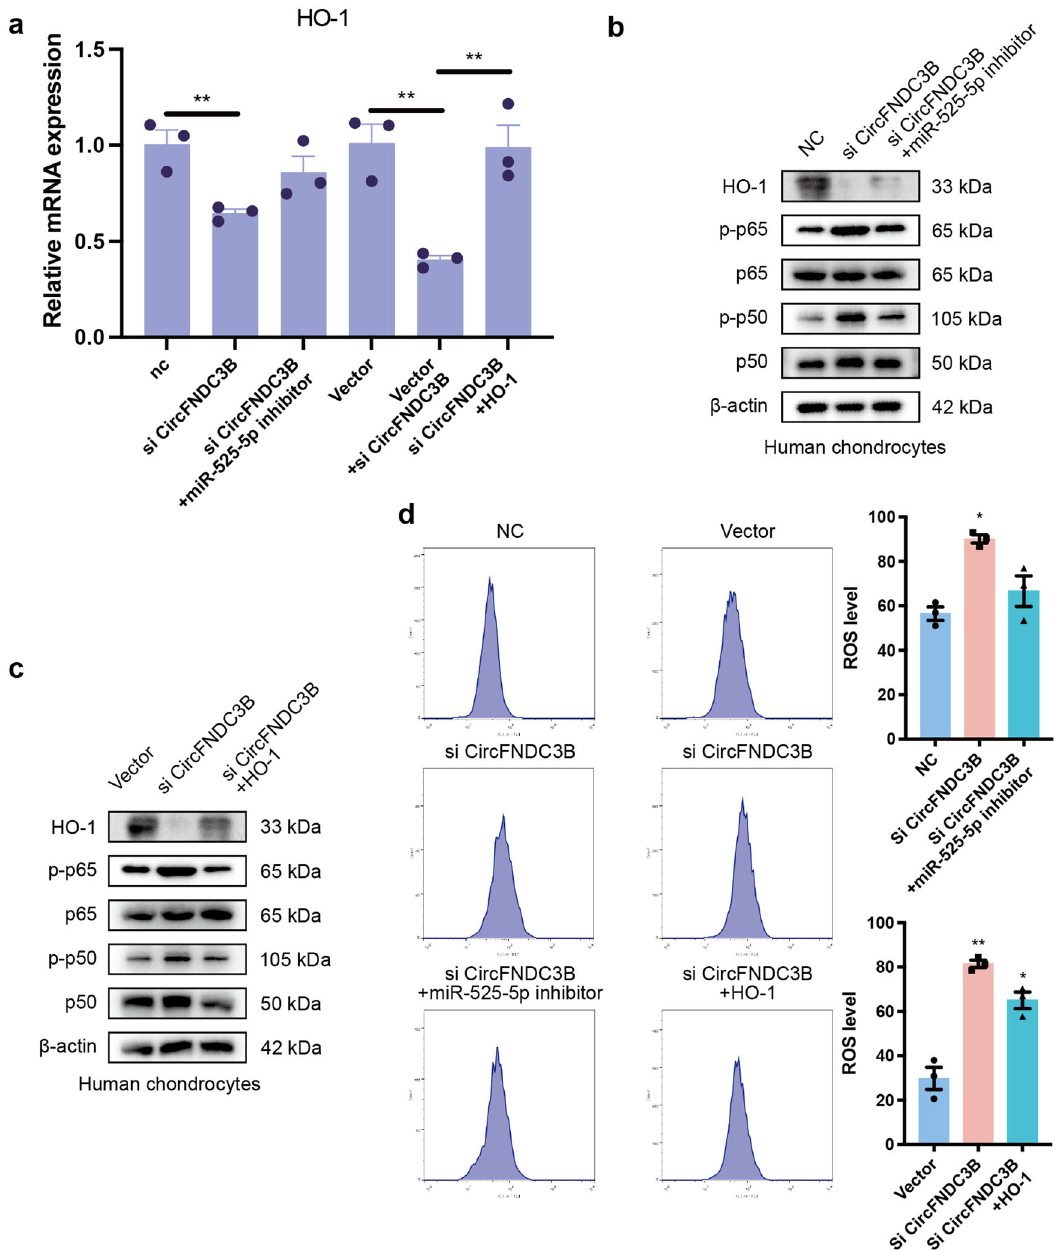
Fig. 8 Oxidative stress and HO-1/ NF- κ B pathway mediates the CircFNDC3B/miR-525-5p/HO-1 axis in OA. a . RT-PCR analysis showed that the downregulation of miR-525-5p or the overexpression of HO-1 antagonized the effect of si-CircFNDC3B on HO-1 in HCs. Vector (empty vector) was used as control. ( n = 3). b , c . Western blot analysis showed that the downregulation of miR-525-5p or the overexpression of HO-1 antagonized the effect of si- circFNDC3B on p65, p-p65, p50, p-p50 and HO-1 in HCs. d . HCs were stained with DCFH-DA, and their oxidative stress was measured by BD FACS Calibur fl ow cytometer. ( n = 3). Mean ± SEM; *p < 0.05; **p < 0.01; ***p < 0.001 by Student ’ s t (Guangzhou, China). RiboBio FISH Kit (Guangzhou, China) was used according to the instruction manual. The images were obtained on Nikon A1Si Laser Scanning Confocal Microscope (Nikon Instruments Inc, Japan). Table S2. Immunohistochemistry . Cartilage specimens were fi xed in 4% paraformaldehyde for paraf fi n embedding and sectioned at 5 μ m. The sections were incubated with primary antibody at 4°C overnight, washed thrice with PBST and incubated with a secondary antibody (Beyotime Institute of Biotechnology, Inc., Jiangsu, China) for 2h at room temperature. RNA fl uorescent in situ hybridization (FISH) . The FISH assay was conducted in Cell viability assay . The cell viability was determined using the Cell Counting Kit- HCs or rabbit tissues. Cy3-labeled CircFNDC3B probes and 488-labeled locked 8 (CCK-8, Dojindo, Kumamoto, Japan). Chondrocytes were seeded into 96-well nucleic acid miR-525-5p probes were designed and synthesized by RiboBio